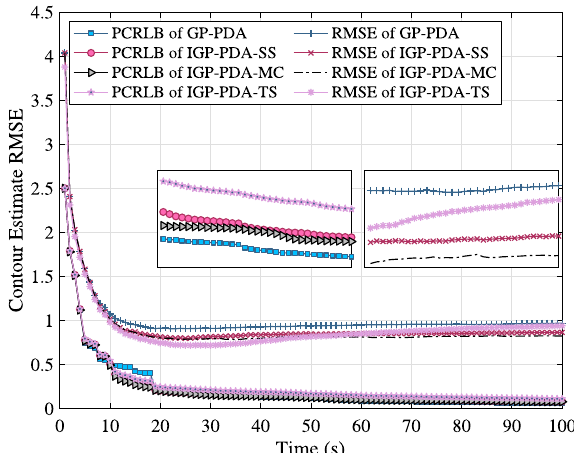
Fig. 9 Contour estimates: RMSE versus PCRLB in the second